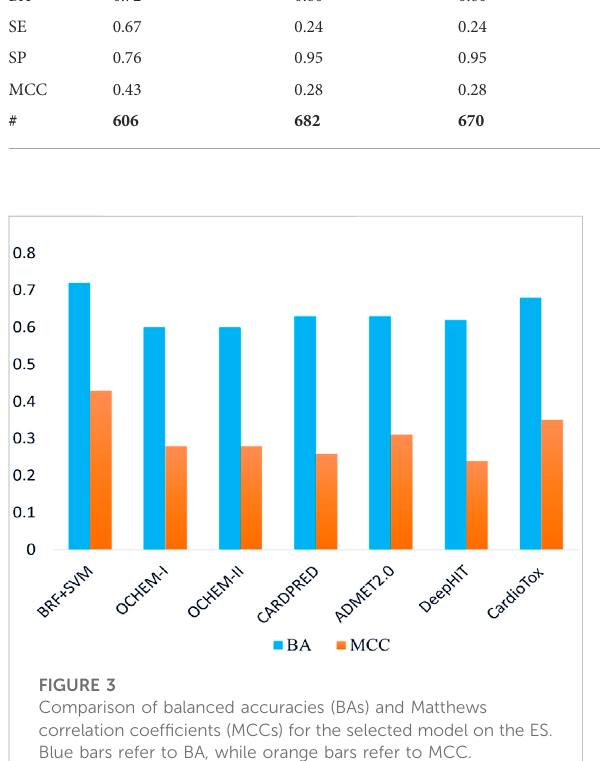
FIGURE 3 Comparison of balanced accuracies (BAs) and Matthews correlation coef fi cients (MCCs) for the selected model on the ES. Blue bars refer to BA, while orange bars refer to